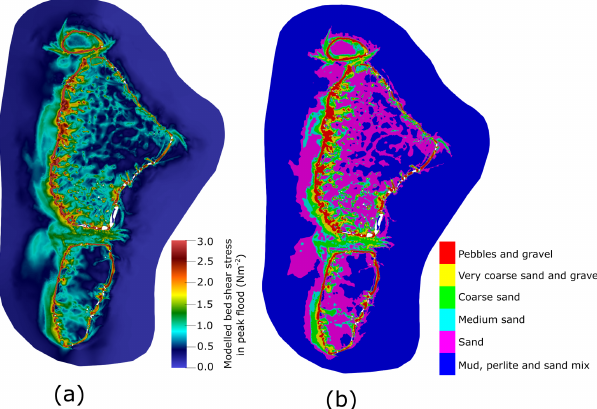
Figure 7. (a) Model bed shear stress values at peak flood. (b) Model bed shear stress values binned according to the grain size tidal proxy. The islands are shown in white with their details presented in Fig. 1. As the model does not include the impact of wind-driven sed- iment processes, differences in grain size in shallow areas (shown in grey in Fig. 1b) might